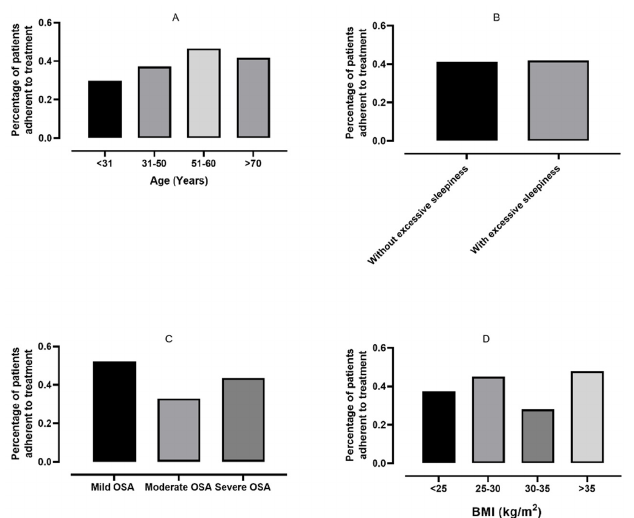
Figure 2. Comparison of adherence among different subgroups. Percentages of patients adherent to continuous positive airway pressure plotted based on age ( A ), excessive daytime sleepiness ( B ), OSA severity ( C ) and body mass index (BMI, D